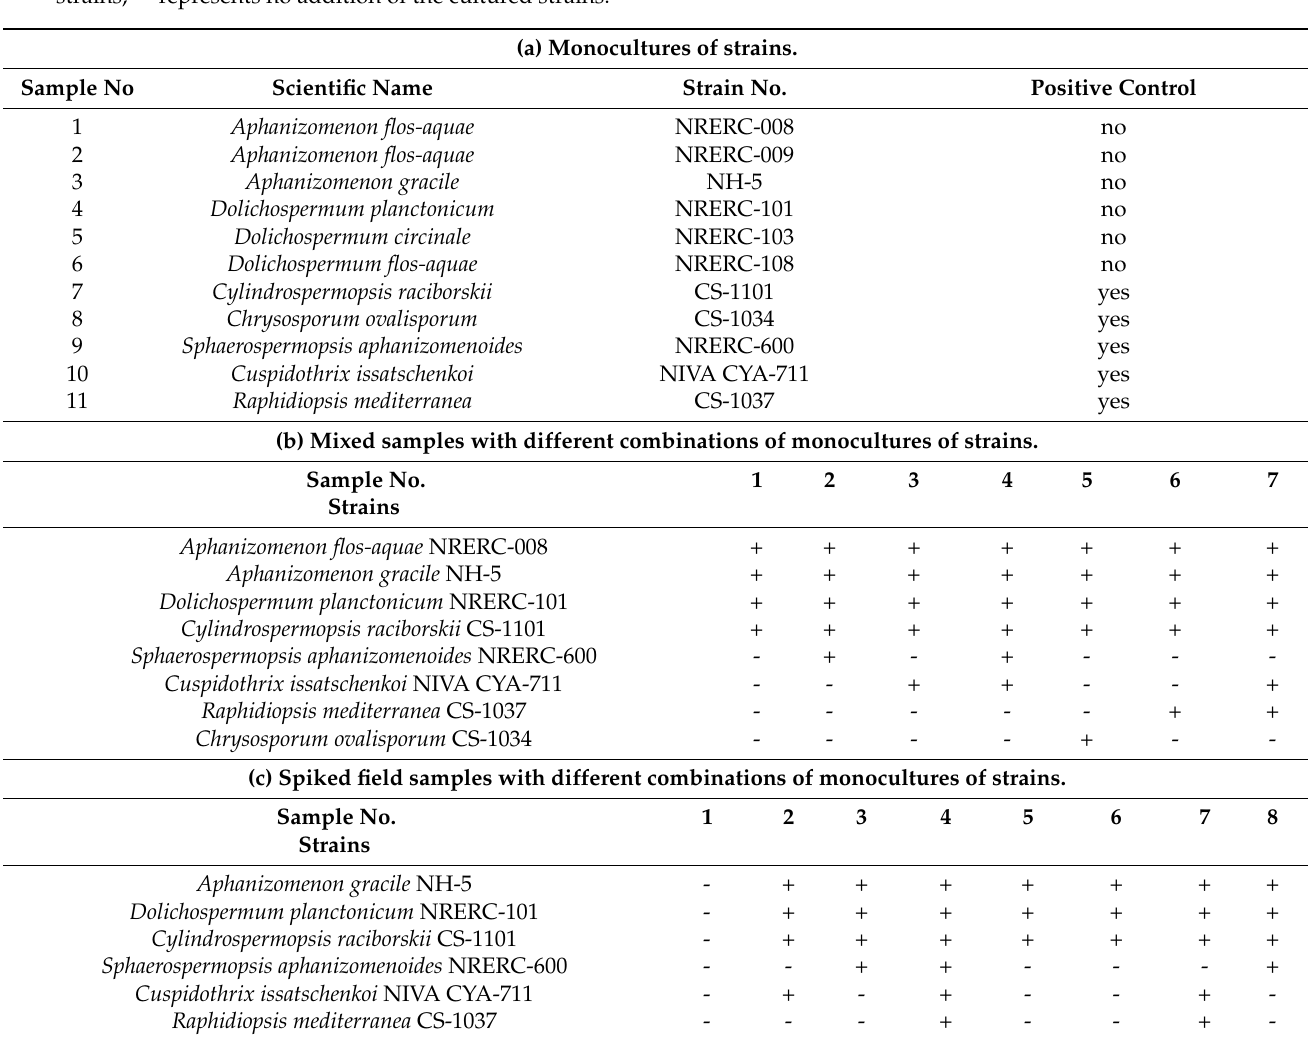
Table 1. List of cultured strains of cyanobacteria ( a ), mixed strain samples ( b ) and field samples (with or without cultured strains added) ( c ) used to test the applicability of developed genus-specific primers; ‘+’ represents addition of the cultured strains, ‘-’ represents no addition of the cultured strains.